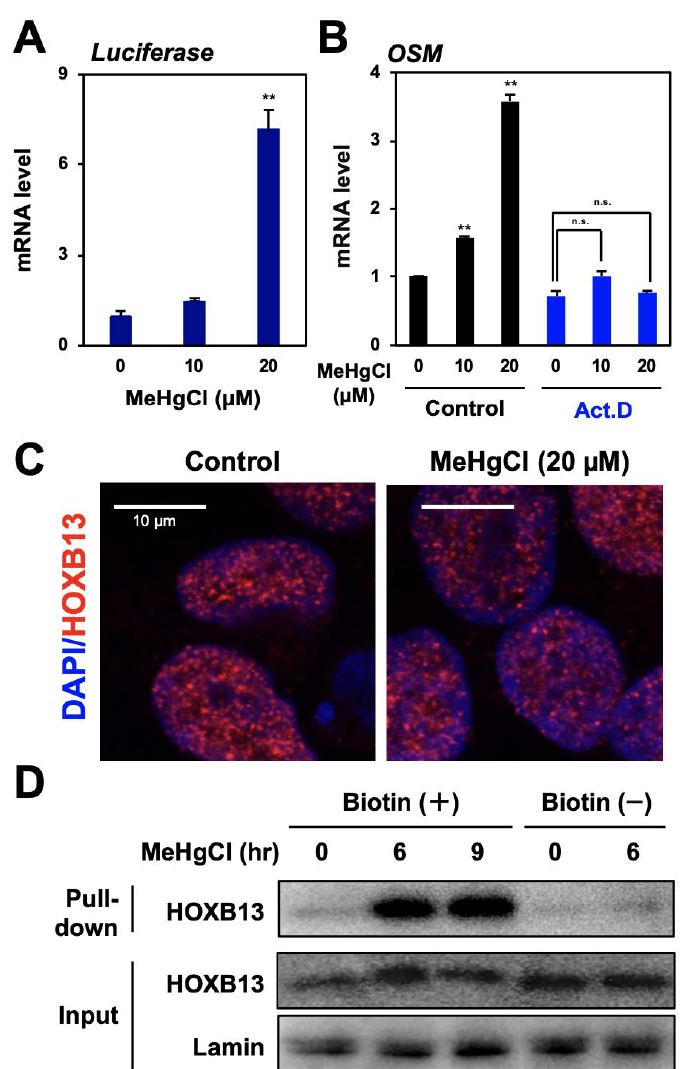
Figure 3. Role of HOXB13 in OSM expression induced by methylmercury. ( A ) HEK293 cells were transfected with a reporter plasmid for OSM gene promoter activity for 24 h and exposed to methylmercuric chloride (MeHgCl) for 6 h. A qPCR for firefly luciferase mRNA was performed. Representative data indicate the relative values, with control as 1, normalized to each GAPDH mRNA level. ( B ) Cells were pre-incubated with actinomycin D (Act. D) for 30 min and exposed to the indicated concentration of MeHgCl for 6 h. A qPCR for OSM mRNA was performed. Representative data indicate the relative values, with control as 1, normalized to each GAPDH mRNA level. ( C ) The cells were exposed to MeHgCl for 6 h, and immunostaining for HOXB13 was performed. Red indicates HOXB13, and blue indicates DAPI. Scale bar indicates 10 µ m. ( D ) Cells were exposed to MeHgCl (20 µ M) for indicated time course, and nuclear fractions were purified and subjected to a DNA–protein pull-down assay. All values are represented as mean ± S.D. of three individual experiments. ** p < 0.01 vs. control siRNA, n.s. indicates not significant.